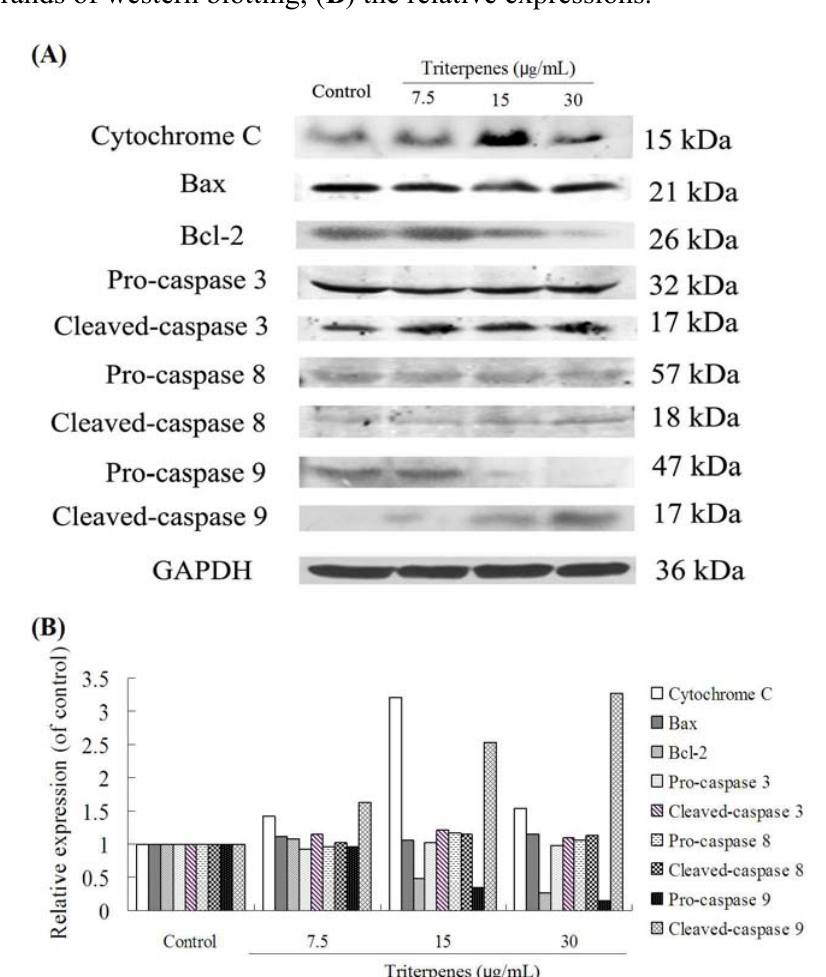
cells. ( A ) brands of western blotting; ( B ) the relative